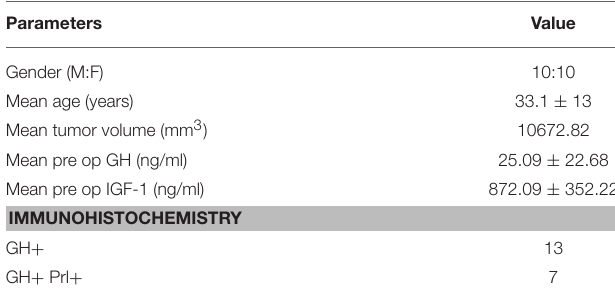
TABLE 1 | Patient characteristics for primary culture of somatotropinoma.